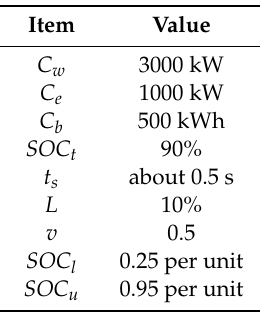
Table 1. Energy management system (EMS)